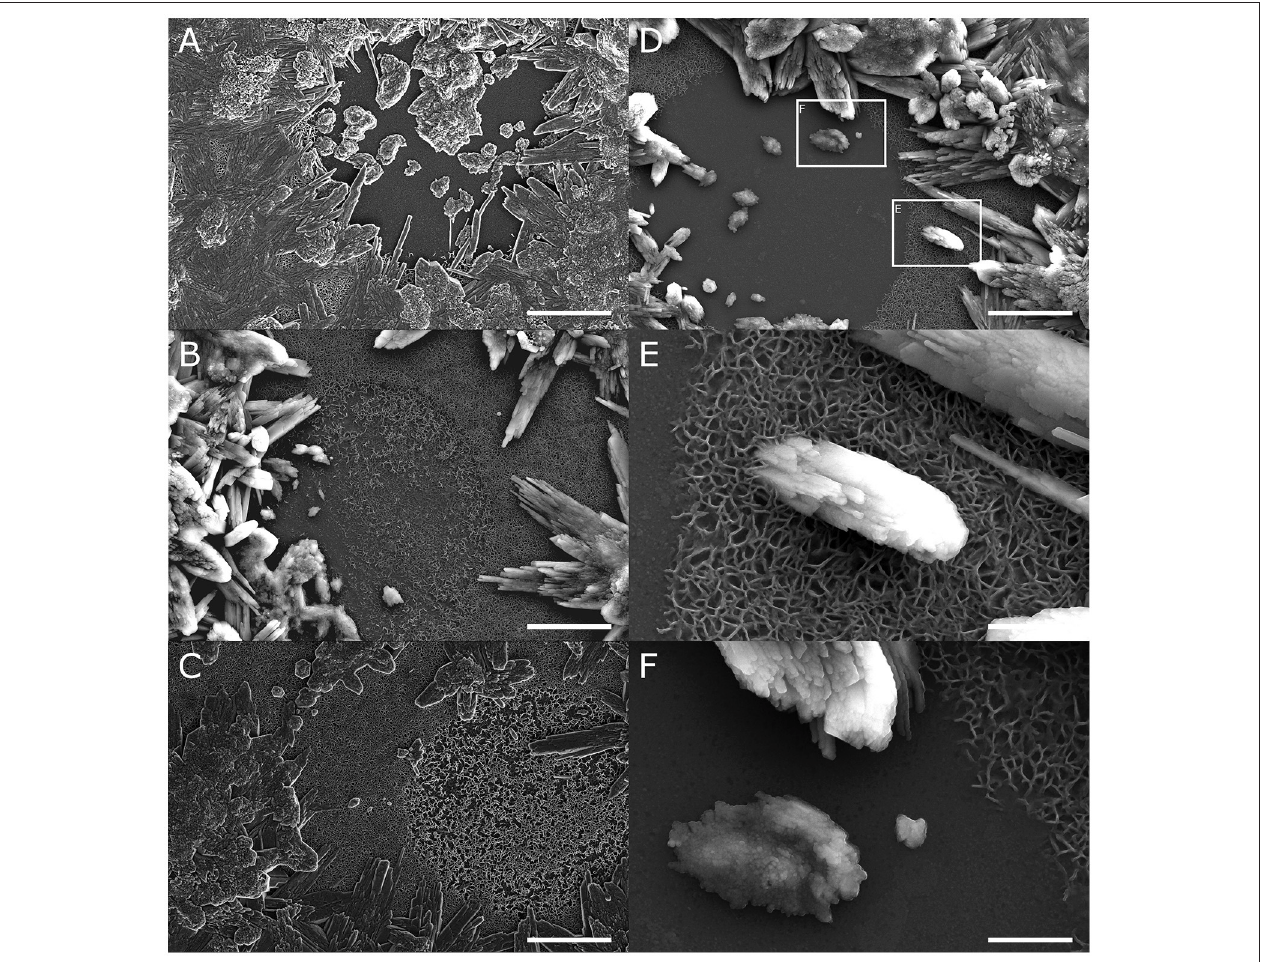
FIGURE 3 | The high magnesium lattice (hml) may direct growth of fibrous aragonite. (A–D) Round or oval patches, approximately 20 µ m in diameter, are frequently observed within the hml, where the structure is either completely absent or appears less dense. Fibrous aragonite is deposited on the hml around these patches but not within them. Scale bars − 5 µ m. (E,F) High magnification of CaCO 3 deposits show a distinct difference between the fibrous aragonite deposited on top of the hml (E) and amorphous structures deposited within patches where hml is missing (F) . Scale bars − 1 µ